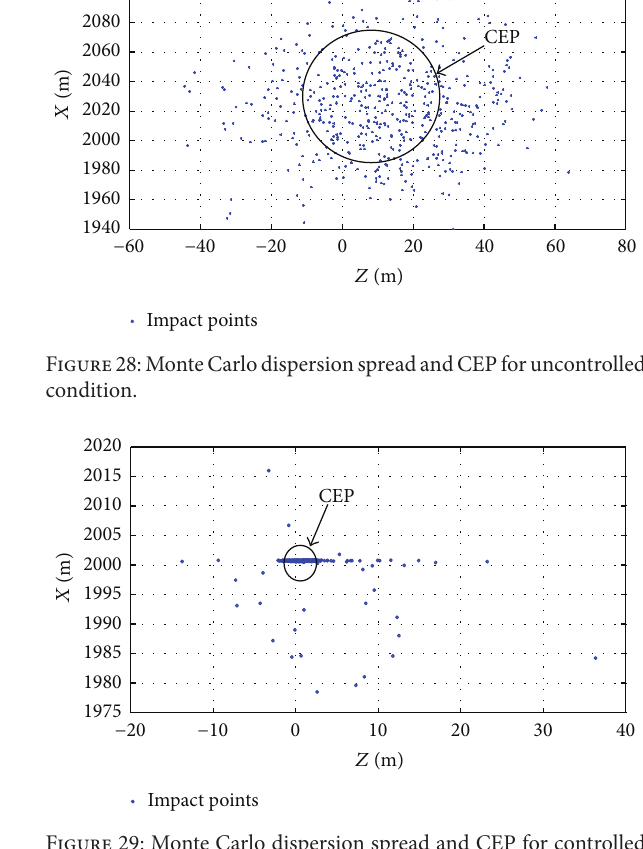
Figure 29: Monte Carlo dispersion spread and CEP for controlled